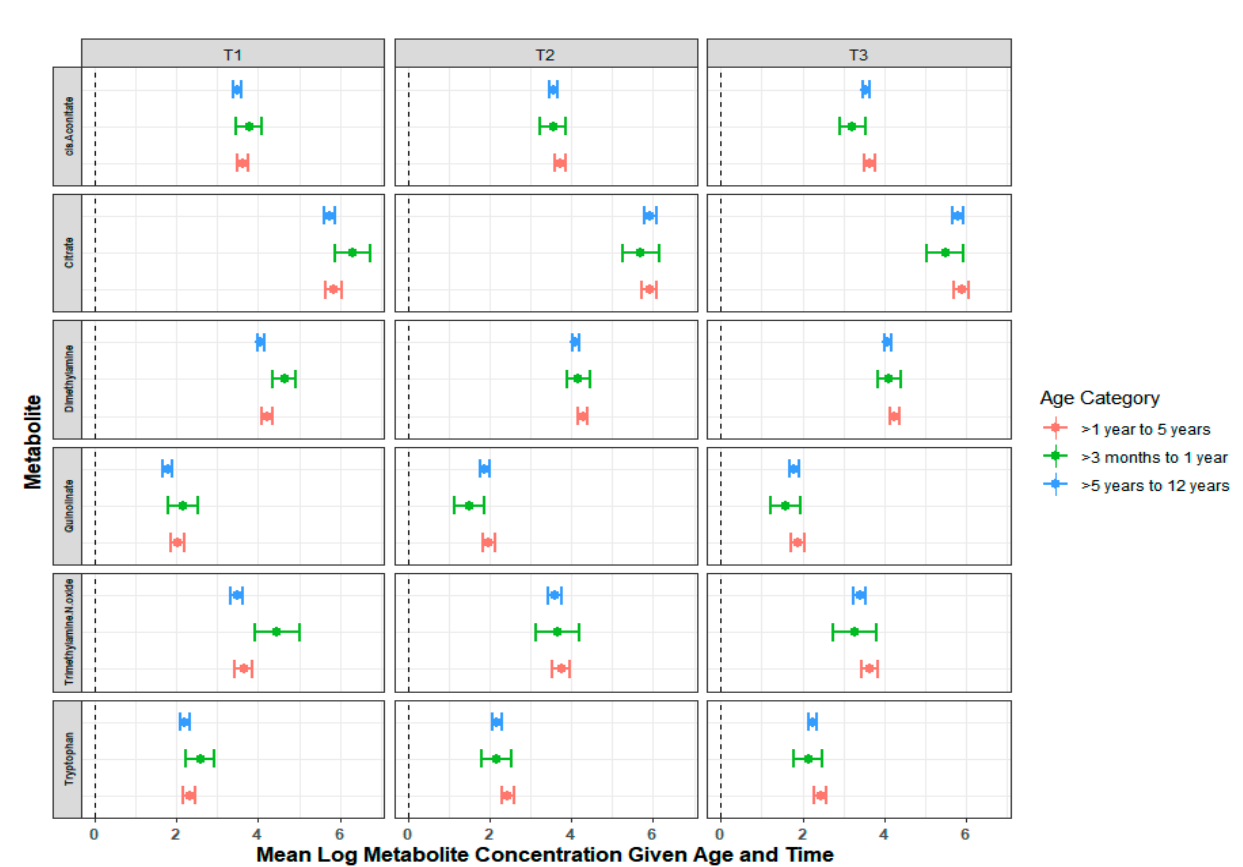
Figure 3. Least square means and corresponding 95% confidence intervals of the log values for the metabolites (concentration in µ M) with a significant age–time interaction from the linear mixed model. Each column presents a unique time point (T1 indicating the initial visit, T2 indicating 24 h after the initial visit, and T3 indicating 10–14 days after the initial visit); metabolites are presented in rows. Children aged >3 months to 1 year represent 5.7% ( n = 7), >1 year to 5 years represent 32% ( n = 39), and >5 to 11 years old represent 62.3% ( n = 76) of the total study cohort. Each colored data point represents a different age